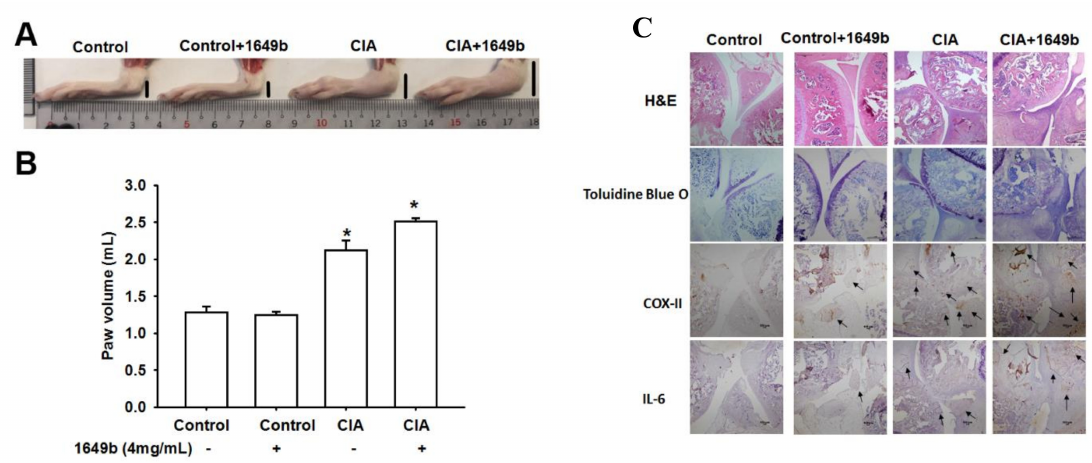
Figure 6. Administration of PMs augments bone erosion and IL-6 and COX-II expression in a collagen-induced arthritis (CIA) model. ( A , B ) Hind paw swelling was photographed and measured with a digital plethysmometer in healthy controls, untreated CIA mice and in CIA mice administered PMs 4 mg / kg ( C ) Histologic sections of ankle joints were stained with H&E and Toluidine blue O or immunostained with COX-II and IL-6 antibodies. Results are expressed as the mean ± SD. * p < 0.05 compared with controls; # p < 0.05 compared with the PMs-treated